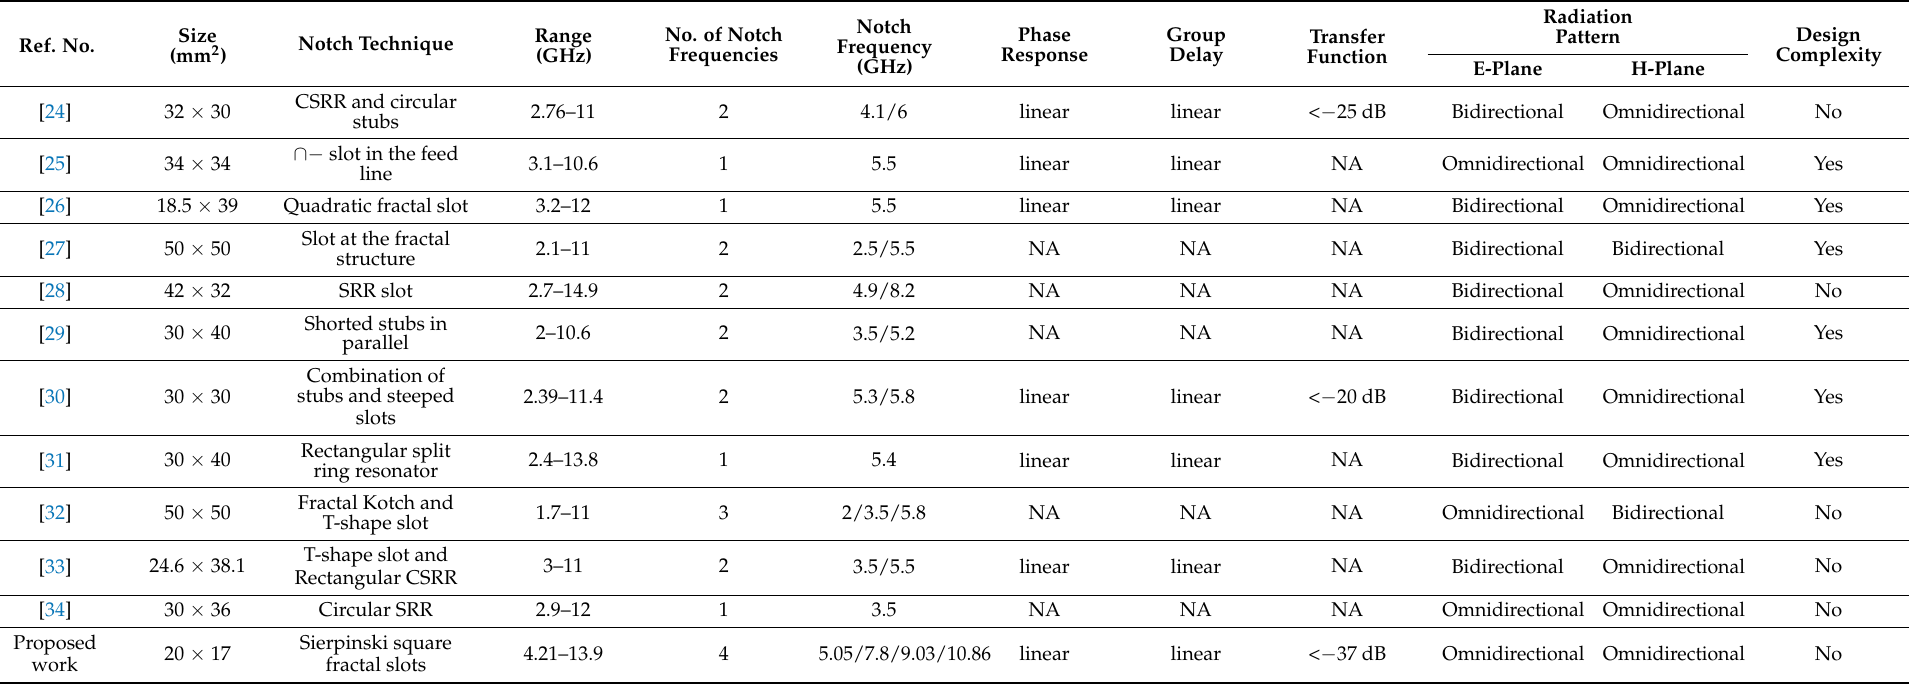
Table 3. Comparison of proposed UWB notch Antenna Performance with Other